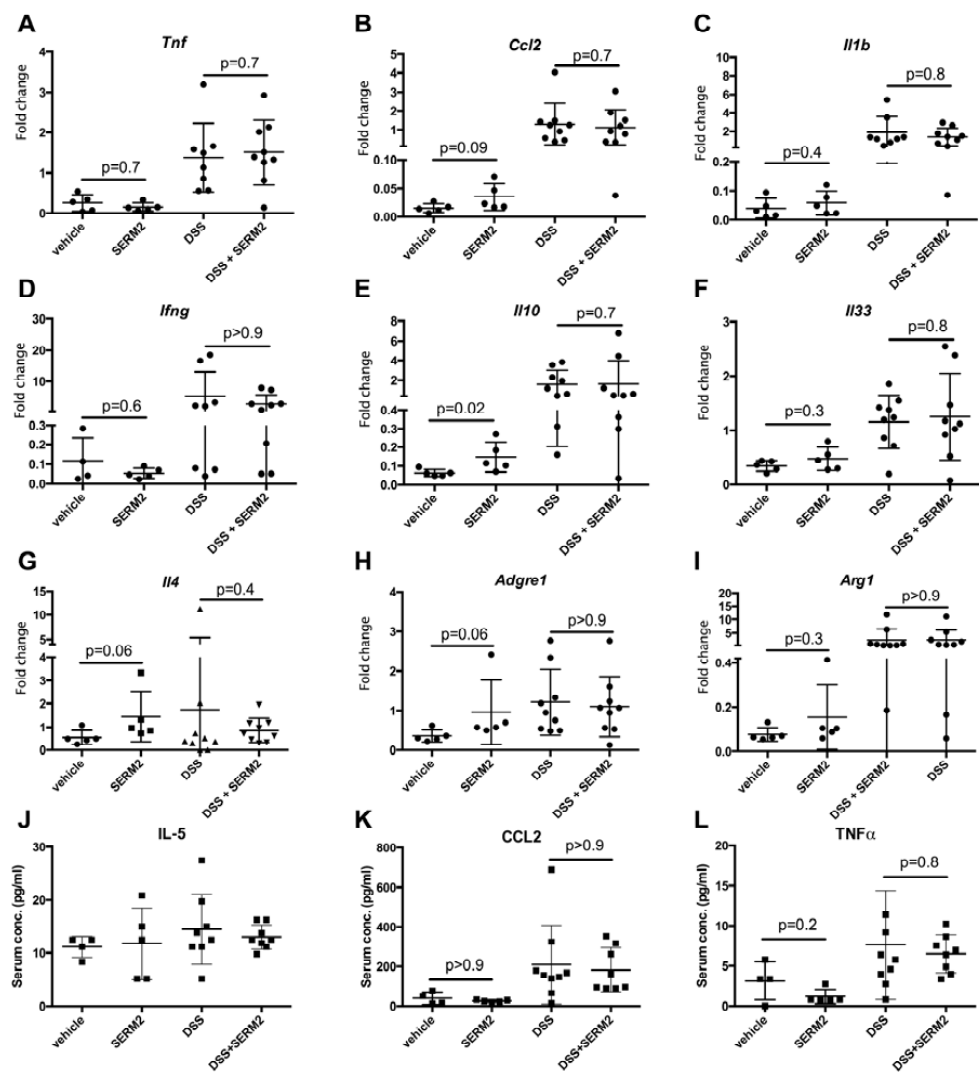
Figure 4. SERM2 promoted local gene expression of anti-inflammatory cytokines in distal colon, but not pro-inflammatory mediators or circulating modulators of inflammation. The relative fold change in gene expression in distal colon tissue, compared to DSS vehicle group of ( A ) Tnf , ( B ) Ccl2 , ( C ) IL33, ( D ) Ifng , ( E ) Il10 , ( F ) Il33 , ( G ) Il4 , ( H ) Adgre1 , ( I ) Arg1 . Bact was used as a house-keeping gene. The circulating concentration of ( J ) IL-5, ( K ) CCL-2, and ( L ) TNF in serum samples. The data are expressed as the mean with SD, one dot representing a tissue sample from single mouse (round dots in panels A–I indicate gene expression and square dots in panels J–L circulating proteins). p -values representing statistical significances for SERM-treatment were calculated using unparametric Mann–Whitney test vs. respective